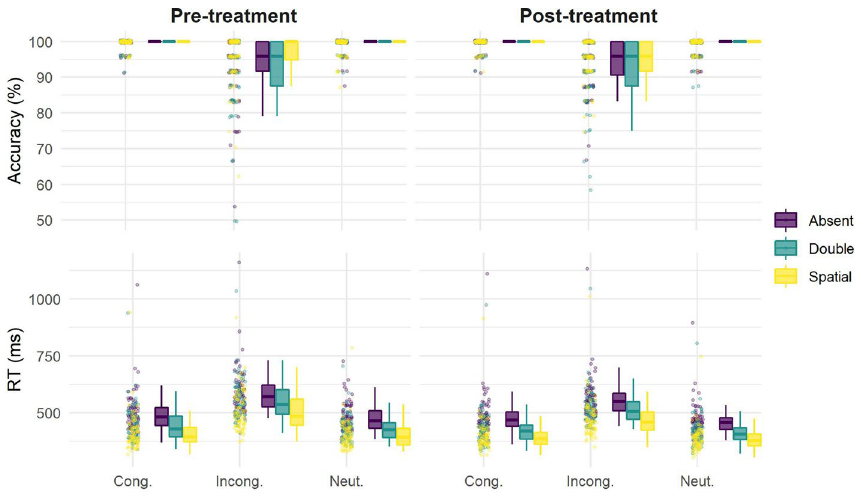
Figure 4. Distribution for accuracy and reaction time in Attention Network Test, showing a boxplot and point distribution of participants’ accuracy (upper part) and reaction time (bottom part) grouped by cue, target and